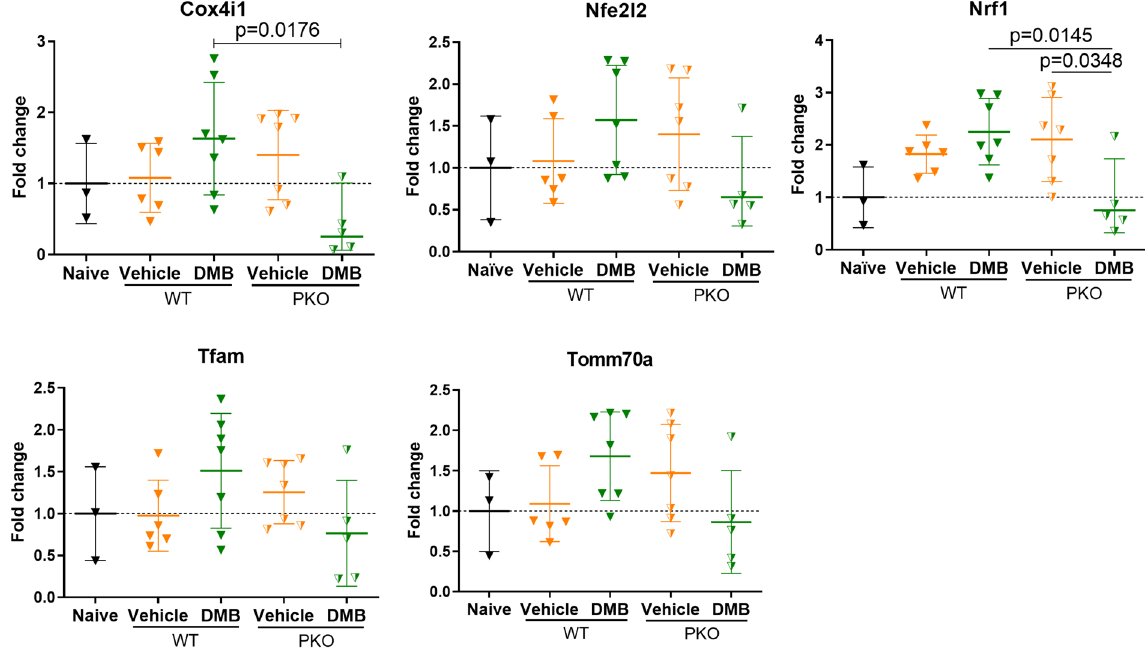
Figure 5. PKO mice exhibit decreased DMB-associated mitochondrial biogenesis gene expression. Age- matched wild-type and PKO mice underwent permanent coronary artery ligation and were given vehicle (50 µ L DMSO) or DMB (10 pmoles/25 g) i.p. 2 hours after surgery and again 2 days later. Mice were sacrificed 3 days after PCAL (n = 3–7 mice/group) for gene expression analysis. All values are presented as mean ±